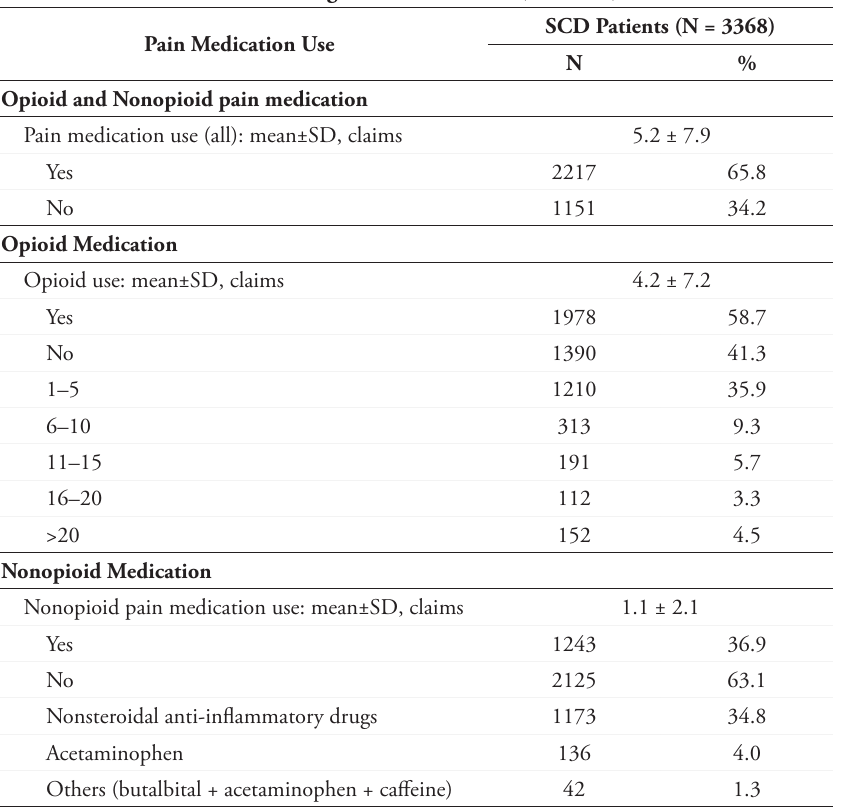
Table 3. Pain Medication Use among Patients with SCD (N = 3368) Pain Medication Use